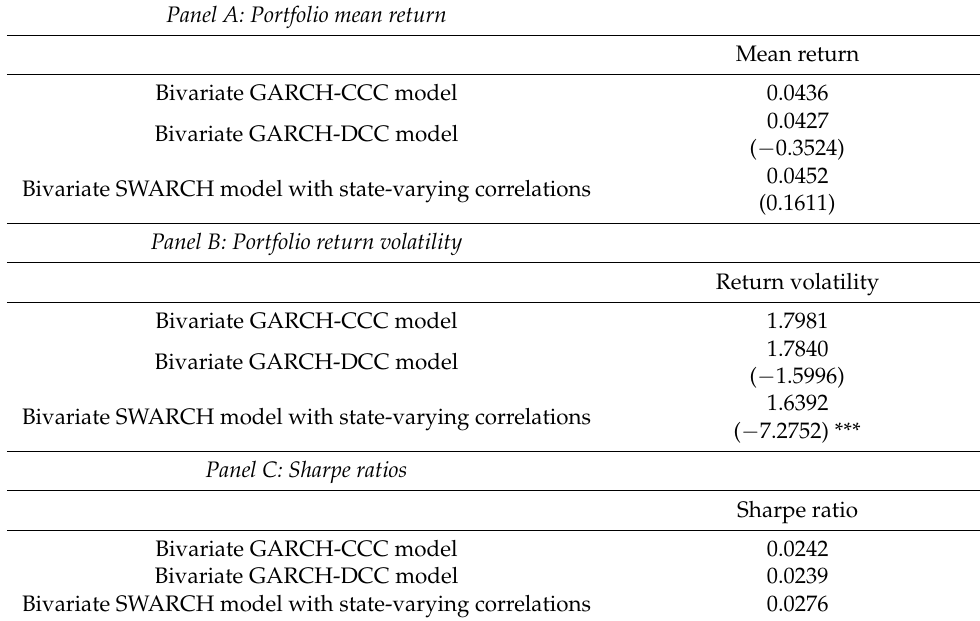
Table 8. Performance of EUA–WTI portfolio construction. Panel A: Portfolio mean